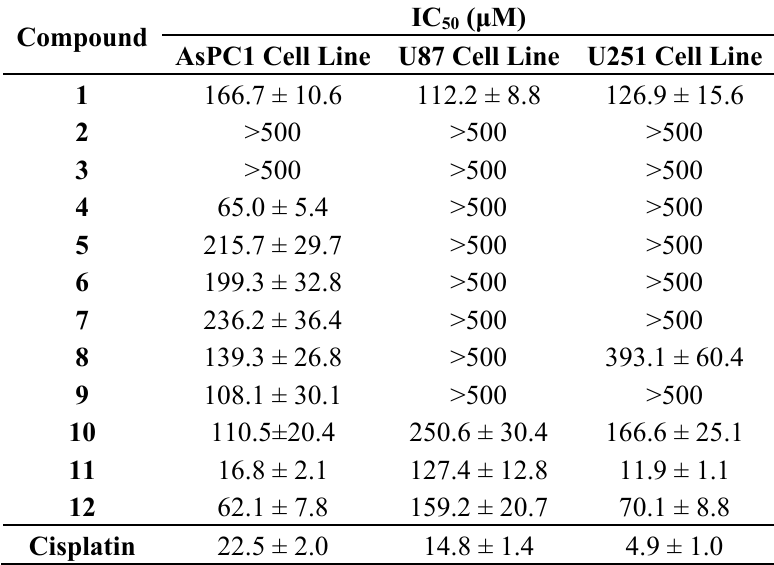
Figure 2. Anticancer effects of compounds 1 – 12 and cisplatin at varying concentrations (10 µM, 50 µM, 100 µM, 200 µM, and 500 µM) against AsPC-1 ( a ); U87 ( b ); and U251 ( c ) cells. Table 1. The cytotoxic effects of the compounds 1 – 12 on the AsPC-1, U87, and U251 cell